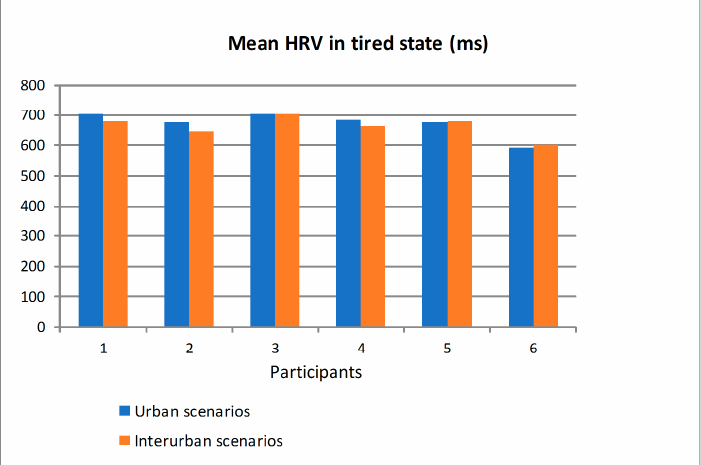
Figure 18. Mean Heart Rate Variability (HRV) of the participants in tired state driving in urban and interurban scenarios.